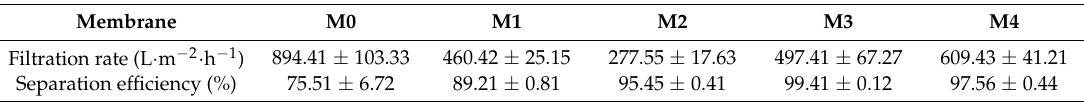
Table 3. Filtration rate and separation efficiency for surfactant-free water-in-oil emulsion of PVDF- HFP porous membranes.